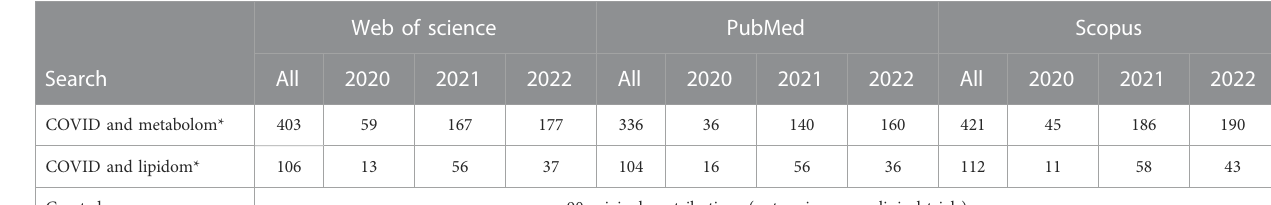
TABLE 1 Summary of the database searches as consulted in 17 November